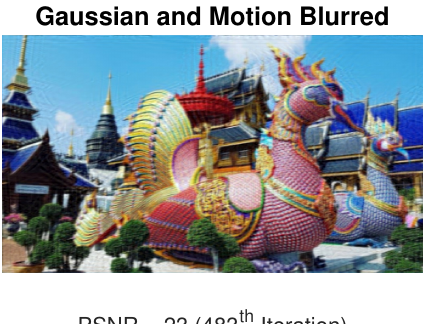
Figure 46. The reconstructed RGB image of all cases using the proposed method (2) with PSNR = 23.